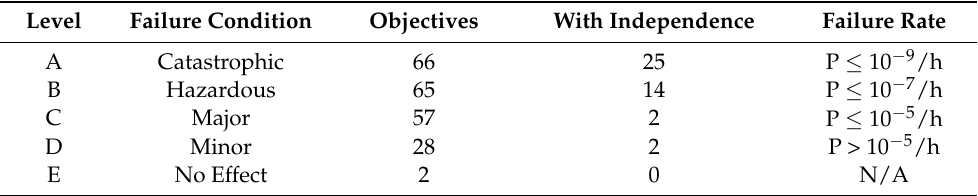
Table 10. Failure condition levels according DO-178B.